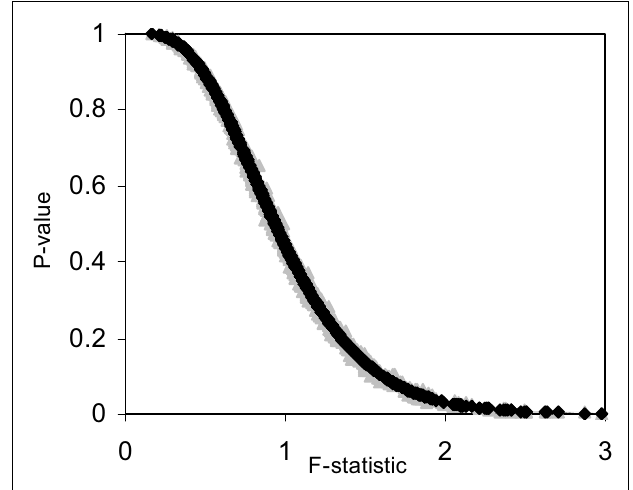
FIGURE 1 | Plot of permutation test-derived p -values as a function of the F -statistic in gray, the corresponding p -values derived from the F -distribution are overlaid in black for 100 samples and 10 random variables following a normal distribution with a mean of 0 and a variance of 1 simulated 1000 times. Fifty samples were coded as control (0) and 50 samples were coded as experiment (1).